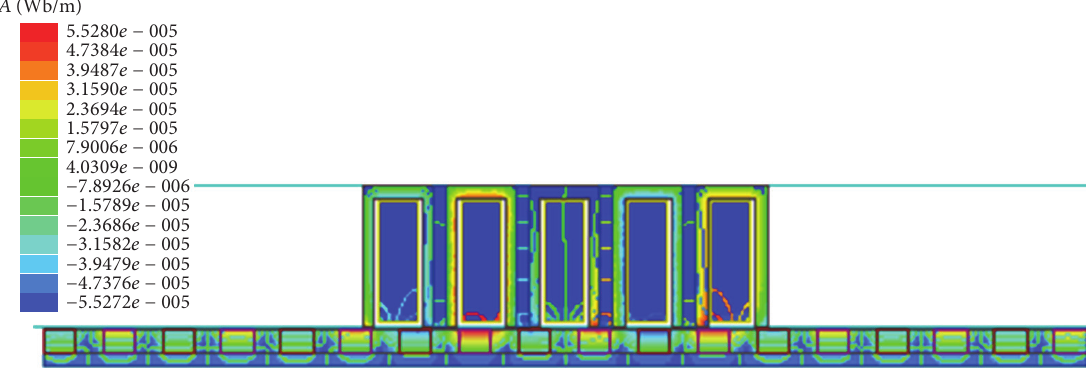
Figure 6: Five-phase FSPMTLM model using finite element